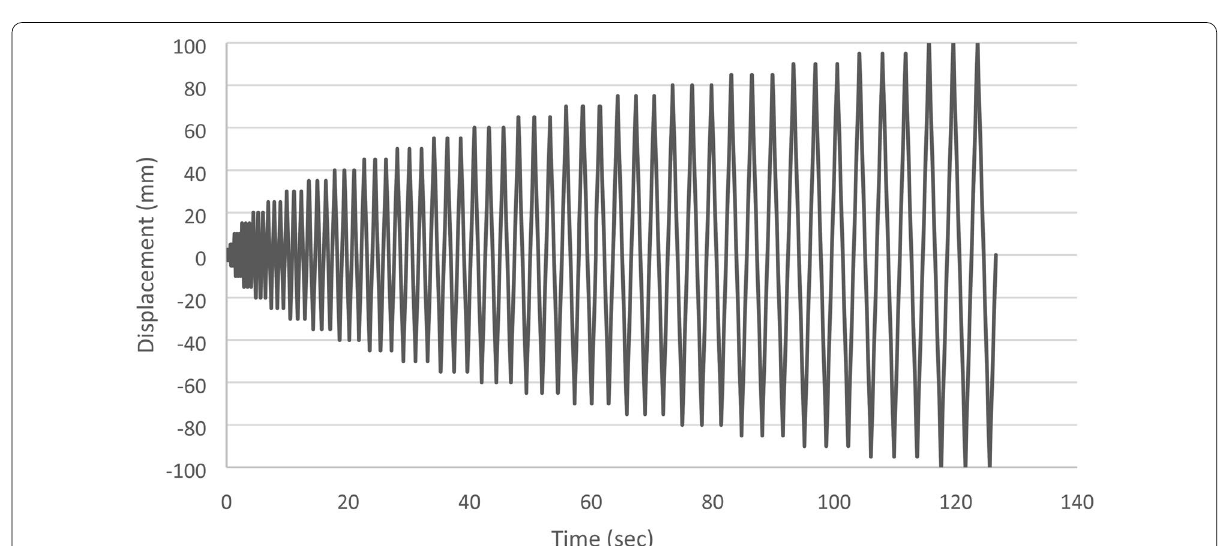
Fig. 5 Time vs. displacement amplitude (ACI Committee 374